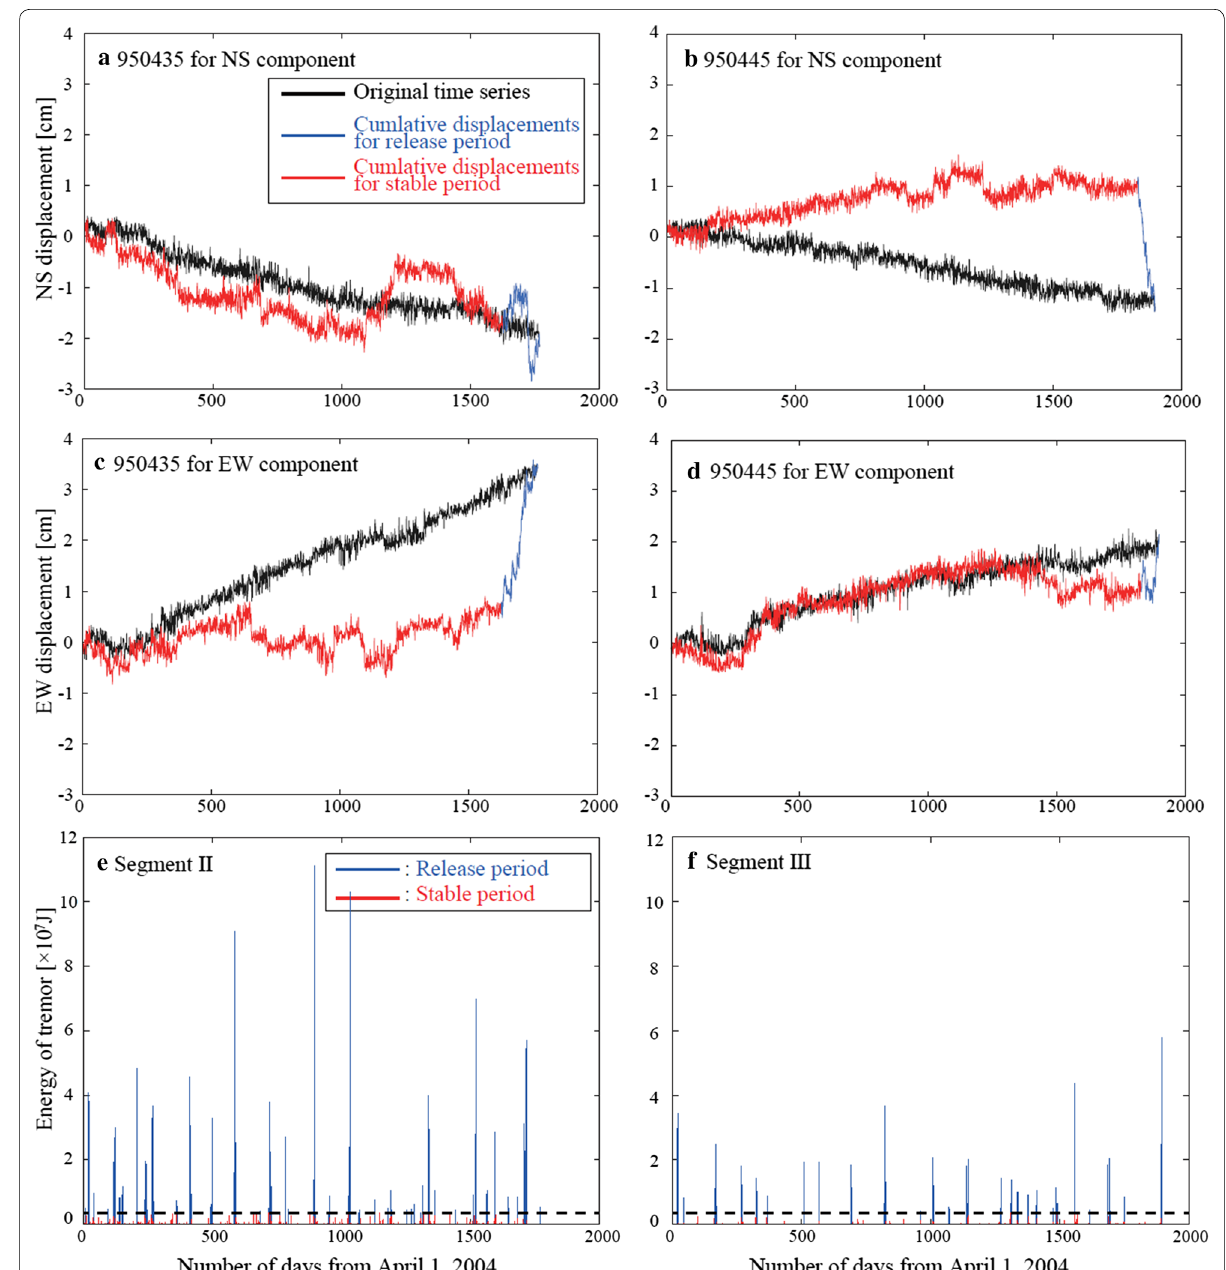
Fig. 2 Rearranged GNSS time series and the time series of the daily sum of tremor energy between 2004 and 2009 with a tremor energy threshold of 0.35 × 10 7 J . a , b GNSS time series for NS component at station 950435 in segment II and station 950445 in segment III, respectively. c , d Same as ( a ) and ( b ), but for EW component. Black, red, and blue traces show the corrected GNSS time series, cumulative surface displacements for the stable period, and cumulative surface displacements for the release period, respectively. e , f Daily sum of tremor energy in segments II and III, respectively. Black horizontal dashed lines show the threshold of 0.35 × 10 7 J . Red and blue vertical bars correspond to the groups for the stable and release periods,